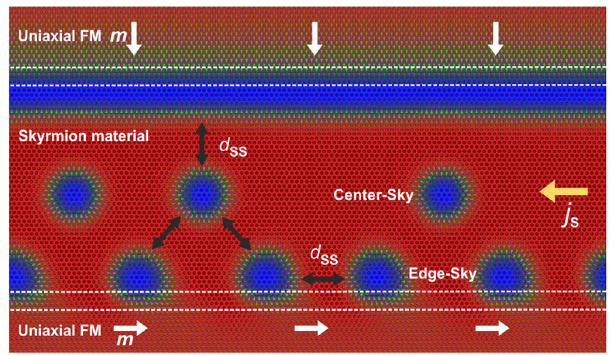
Fig. 8 Racetrack with edge-skyrmions. Possible racetrack structure with edge-skyrmions functioning as spacers between skyrmion bits. The material parameters are the same as shown in Table 1 with exchange interaction J = 2.86 meV/atom and Dzyaloshinskii – Moriya interaction D = 0.76 meV/atom in the transition area. At the upper rim, the in-plane magnetization component m of the ferromagnetic (FM) Co/Fe is orthogonal to induce a skyrmion-repelling spiral stripe. Center- and edge- skyrmions are moved simultaneously by a spin-polarized current j s . The minimum distance between two skyrmions d SS is determined by repulsive skyrmion-skyrmion interactions. Red and blue areas represent spins pointing in opposite out-of-plane directions, while in-plane pointing spins are green. B = 1.5 T and T = 0